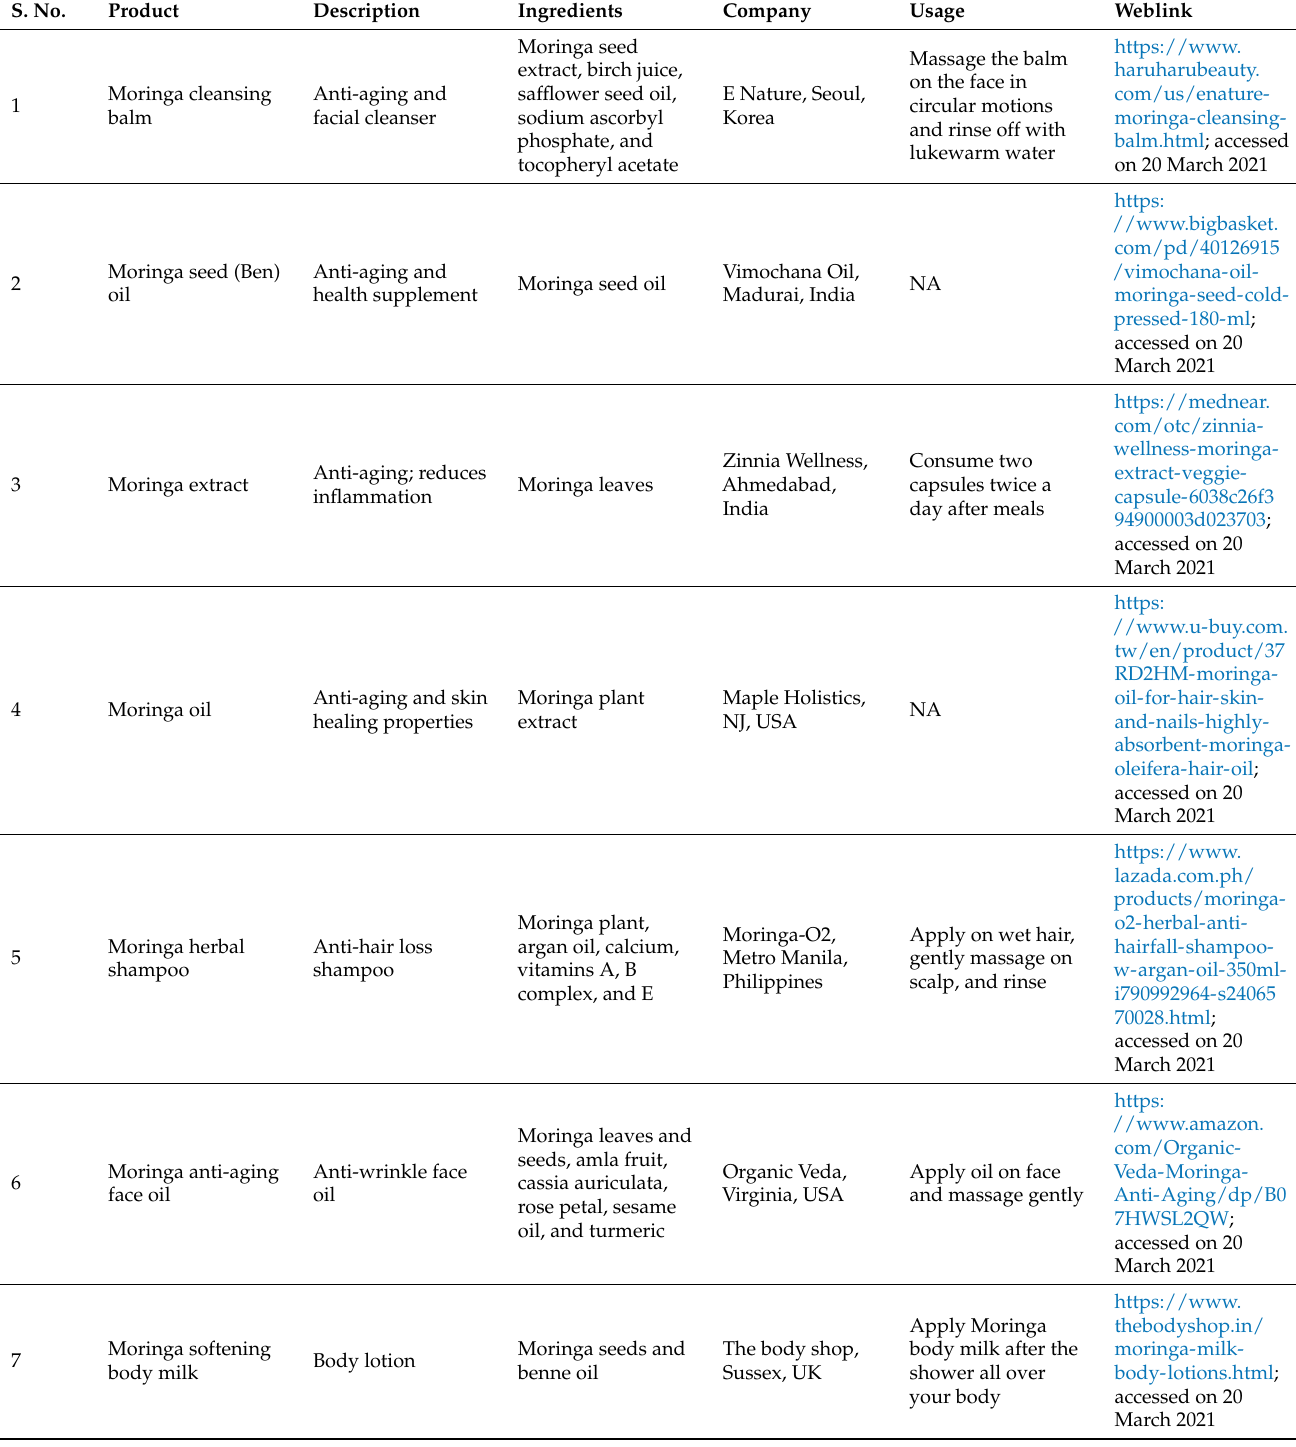
Table 5. Commercial details of Moringa non-food